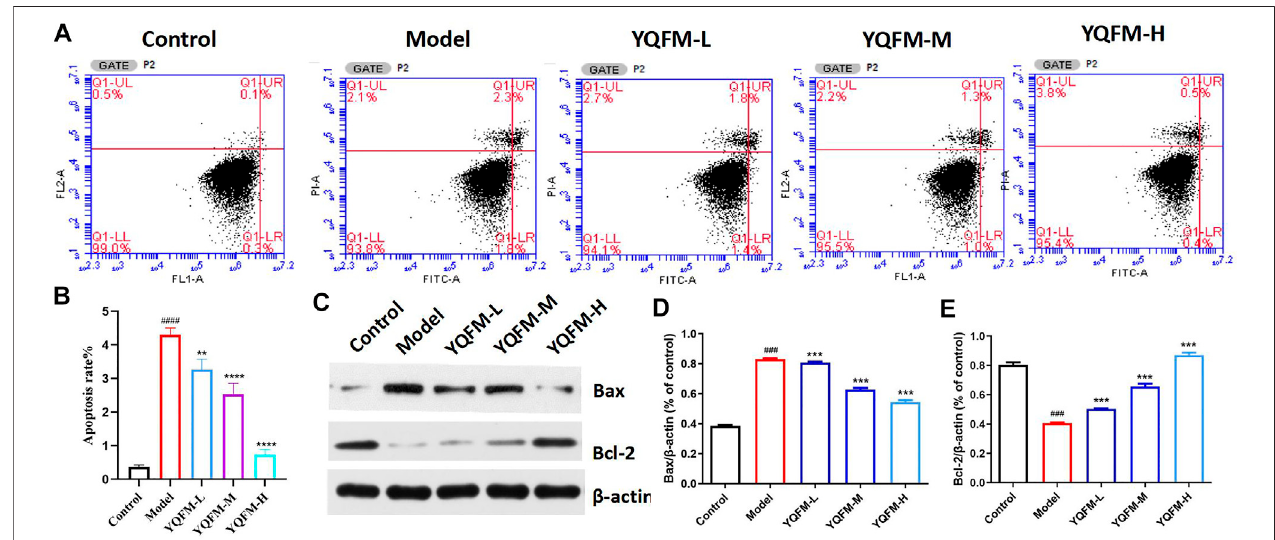
FIGURE 10 | YQFM suppressed cardiomyocyte apoptosis caused by H 2 O 2 . (A,B) Flow cytometric measurement of H9C2 cells apoptosis caused by H2O2. (C) The amount of Bax and Bcl-2 from H9C2 cells lysate was examined by Western blot analysis. (D,E) Relative protein levels were measured by densitometry for Bax and Bcl-2 ( n (cid:2) 3 per group). Data are means ± SD. * p < 0.05, ** p < 0.01, *** p < 0.001 vs the Model group, # p < 0.05, ## p < 0.01, ### p < 0.001 vs the Control